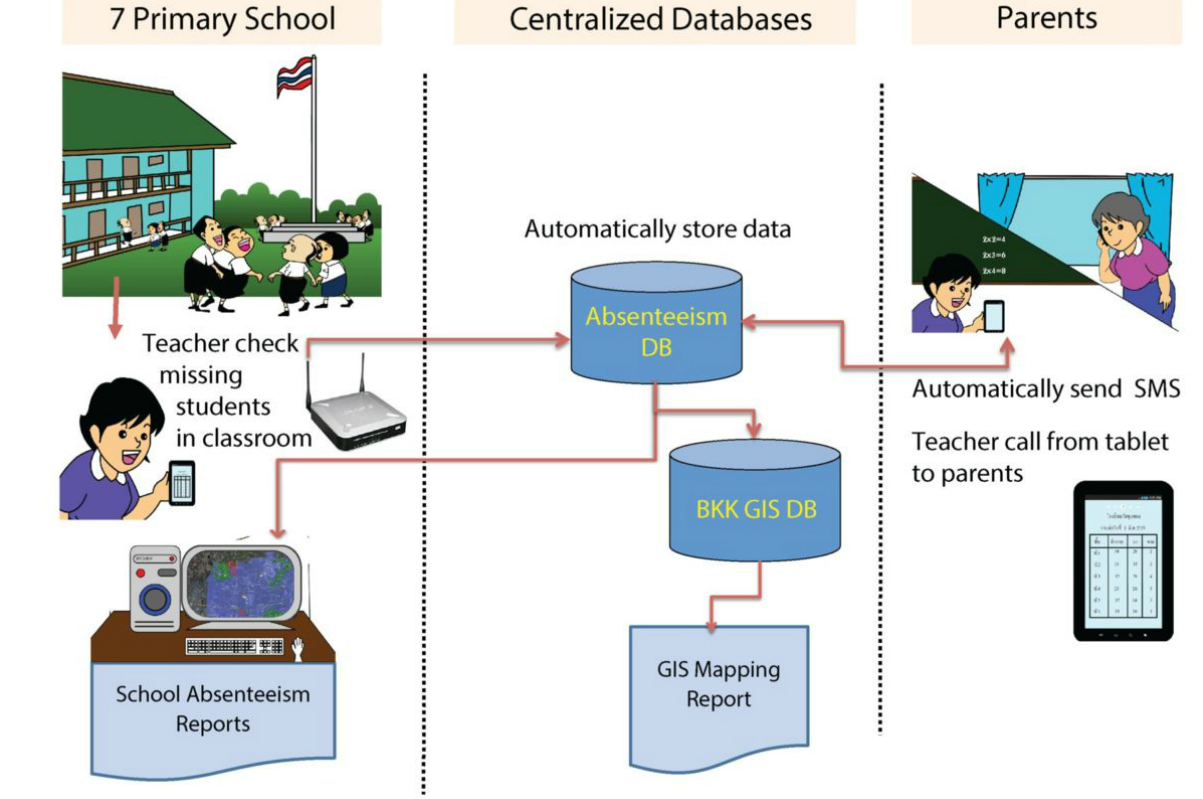
Figure 3. Revised data and work flow of the school absenteeism reporting system.